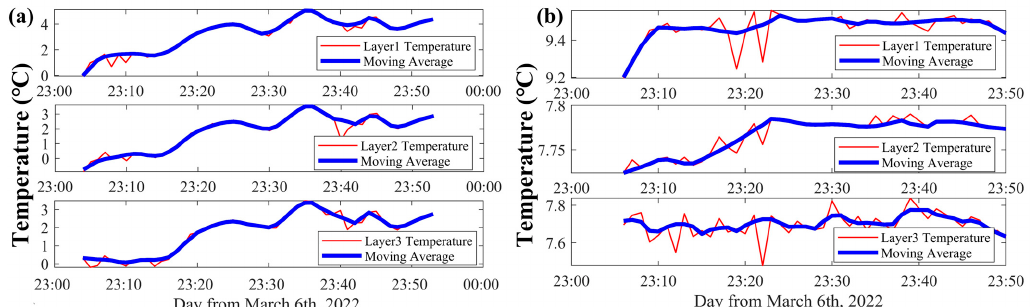
TD data. Figure 9c–h show a clear temperature layer stratification, and the 2D temperature color maps of S1–S3 and S1–S4 are similar. The inversion result in this paper still has a small error, but these two methods can largely reduce the travel time error caused by station drift.